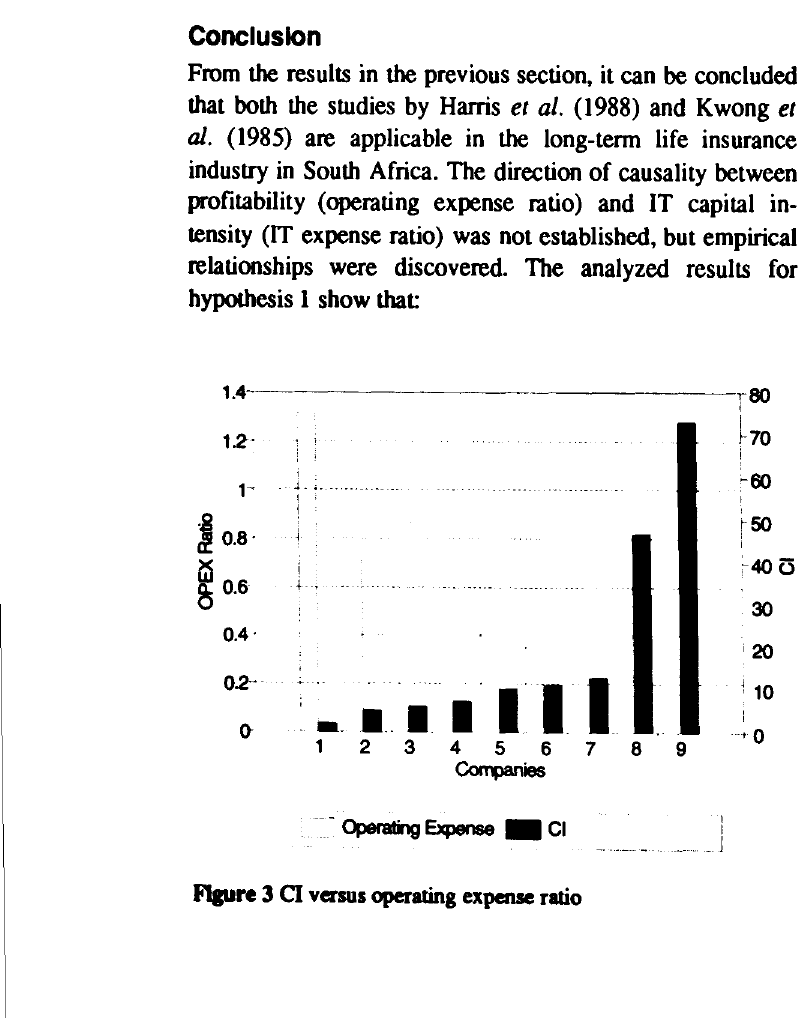
Figure 3 CI versus operating expense